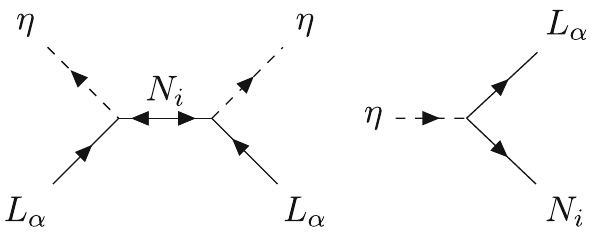
Fig. 8 Diagrams leading to γ eq s (η L → η L ) (left) and γ D (η → N 1 L ) (right),